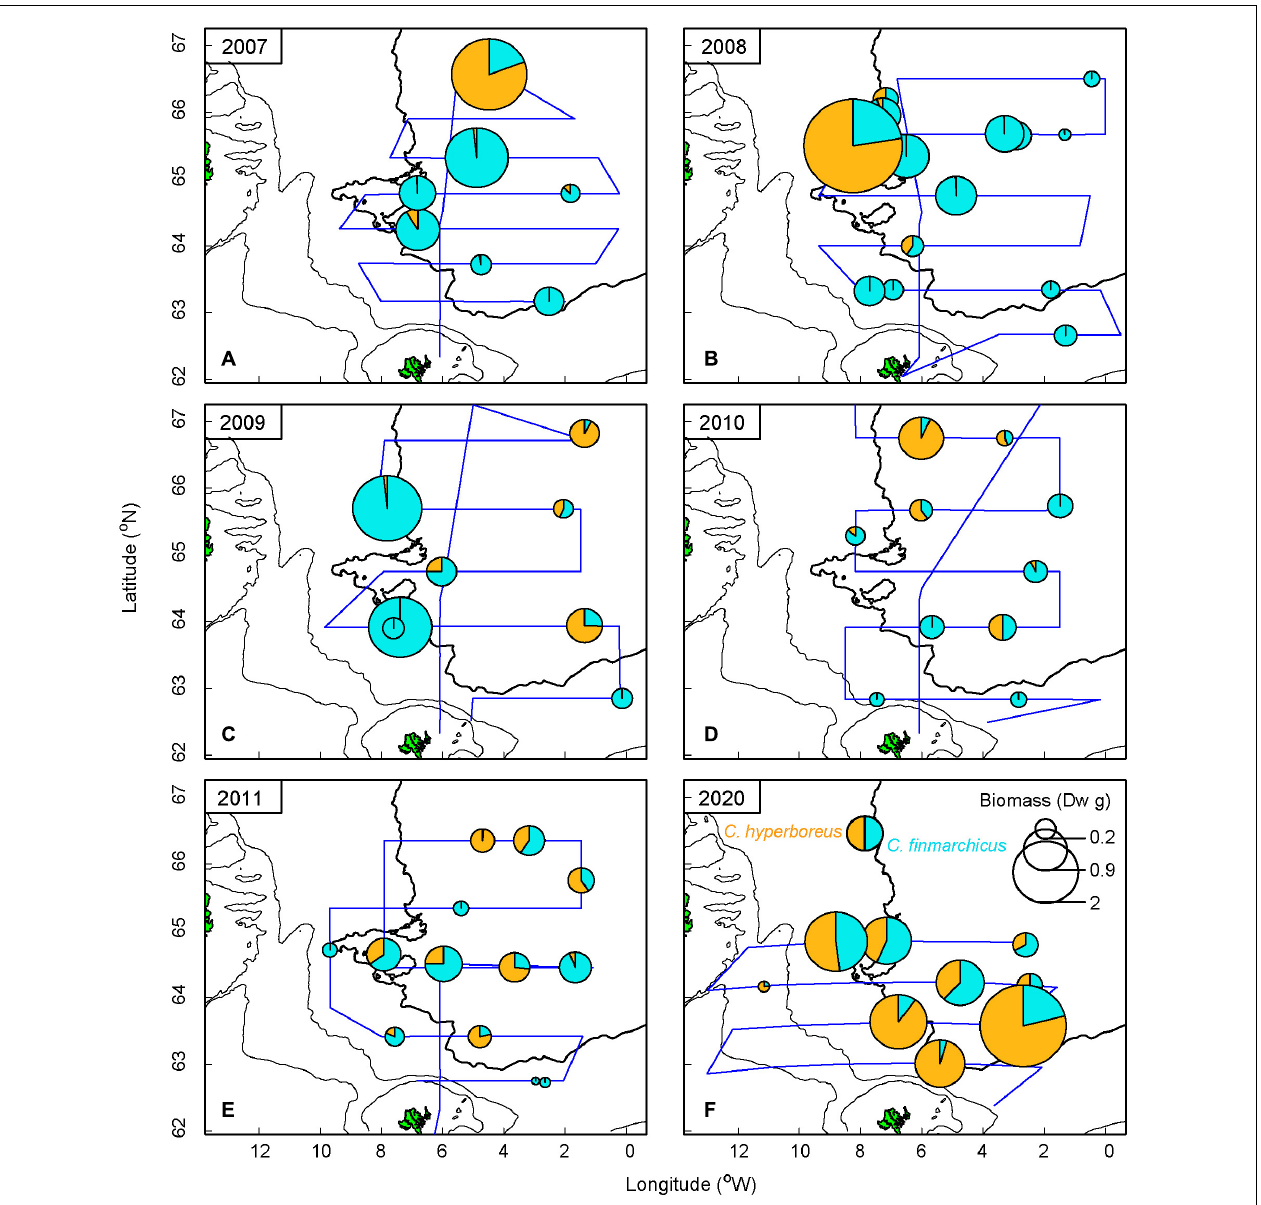
FIGURE 4 | Dry weight (Dw) of diet composition of the most common copepods— Calanus finmarchicus and Calanus hyperboreus —found in herring stomachs. Observations are from 2007 to 2011 (A–E) and 2020 (F) . The blue line represents cruise tracks each year. Data analysis on diet composition is not available for the years 2017–2019. The 2,000 m depth contour is shown in